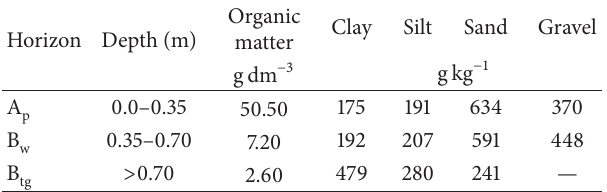
Table 1: Soil texture data for a representative profile of the study